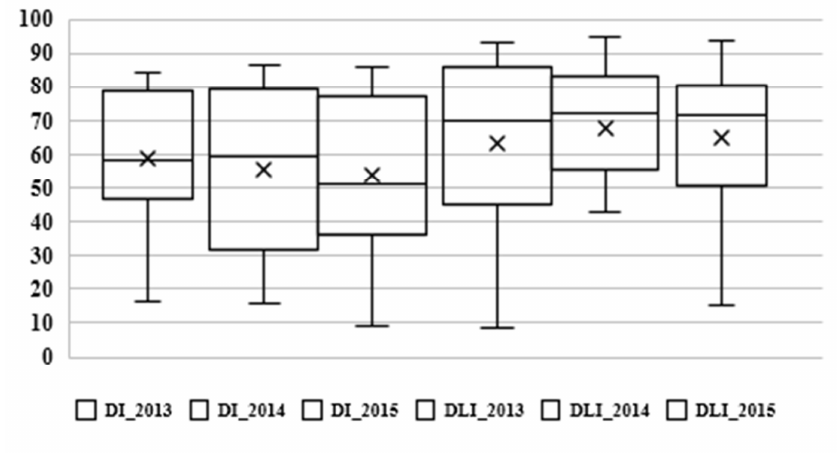
Figure 4. Share of shipped products of innovative sector in total shipped products of the branch of industry, %